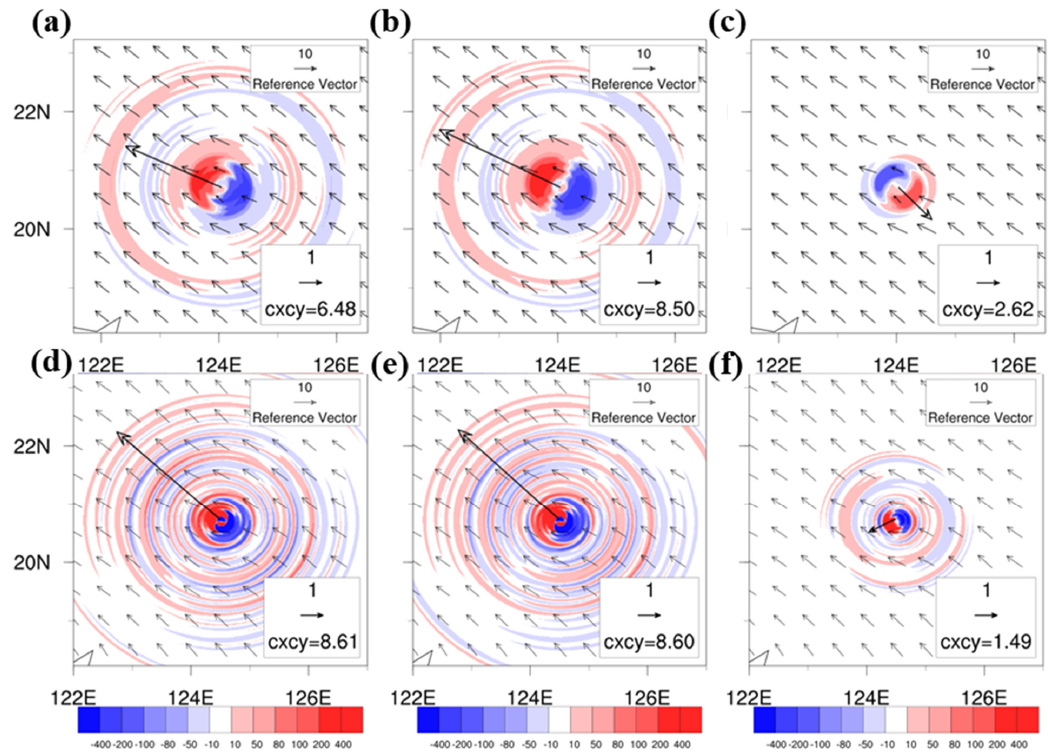
Figure 16. Wavenumber-one (WN-1) PV tendency budget (shaped colors in 10 − 5 PVU s − 1 ) averaged at 1–8 km height at 0000 UTC 7 July 2016 for BND for ( a ) net PV budget, ( b ) PV horizontal advection, and ( c ) differential diabatic heating, with the overlaid WN-1 horizontal flow (vectors in m s − 1 ). ( d – f ) are the same as ( a – c ), respectively, but for BND_H. The regressed typhoon translation velocity (m s − 1 ) is indicated by the vector at the typhoon center with the magnitude given at the lower right of each panel. A reference wind vector (m s − 1 ) is given in the upper right for the WN-1 flow in each panel.